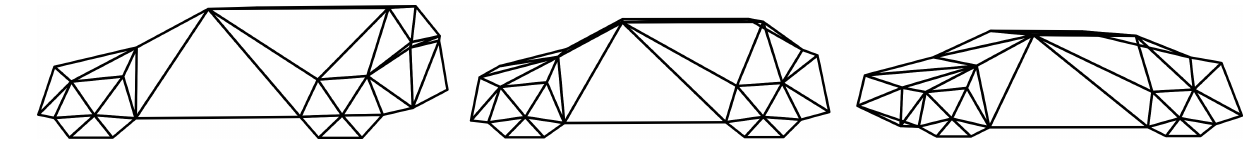
Figure 3. 3D Object Model. Mean shape (center, γ = (0 , 0) ) and two instances illustrating the range of possible deformations with shape parameters γ left = ( − 1 . 0 , − 0 . 8) and γ right = (1 . 0 , 0 . 8) .